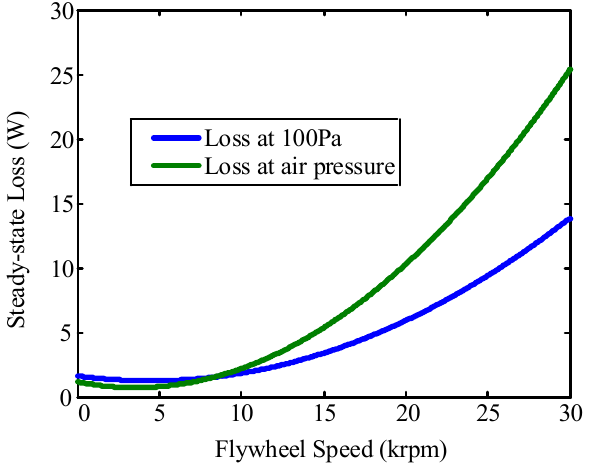
Figure 19. Steady-state power consumption curve under air and rough vacuum.